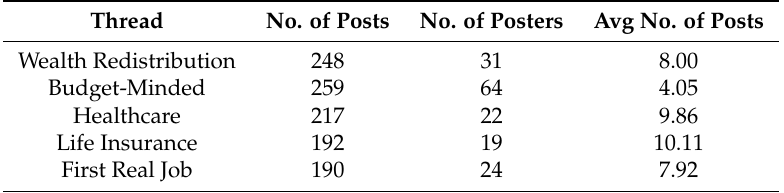
Table 1. Dataset